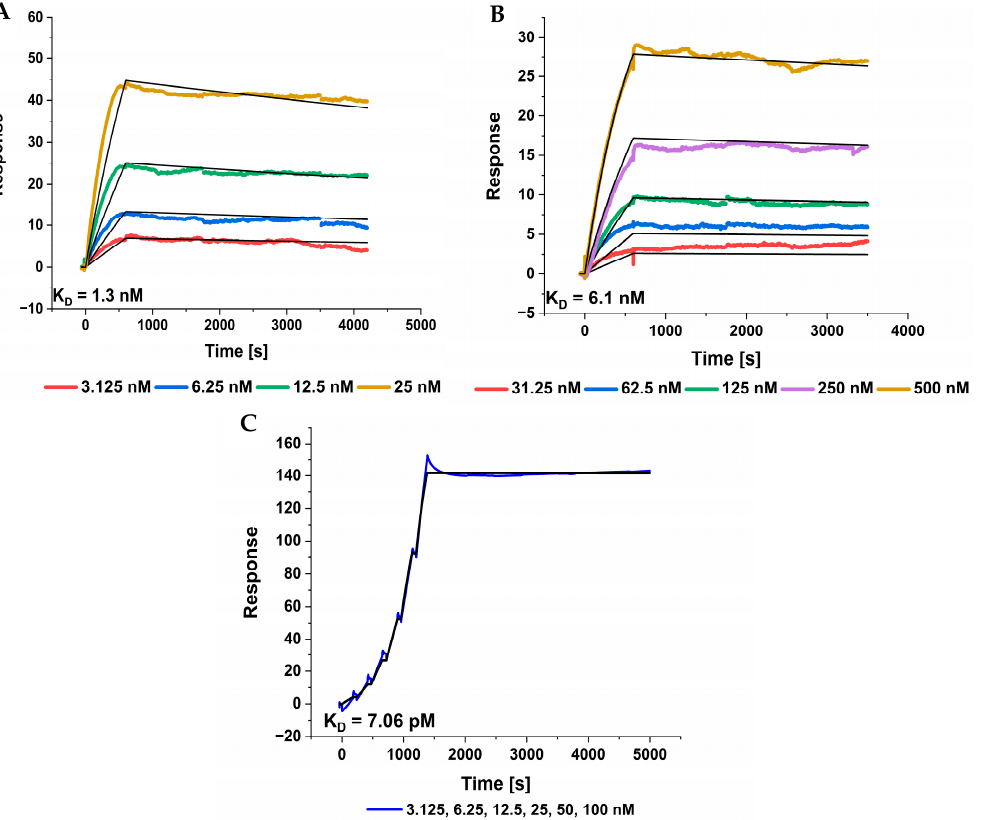
Figure 8. SPR measurements of TF2D-5 and TF2D-5a with monomeric full-length tau 441 and tau repeat region 3. ( A ) Binding curves and calculated fit for the affinity of TF2D-5 for monomeric full-length tau 441 resulted in a K D of 1.3 nM. The concentration of tau during the measurement ranged from 3.125 nM to 25 nM. ( B ) Binding affinity of TF2D-5a for monomeric full-length tau 441 was determined to be 6.1 nM. Tau was used in concentrations ranging from 31.25 nM to 500 nM. SPR measurements of A and B were recorded on a T200 Biacore instrument, the corresponding compound was immobilized on a CM5 chip from Cytiva while monomeric tau served as analyte. Tests were performed with TBS pH 7.4, 0.05% Tween20 and 10 µM DTT as running buffer. Fit calculation was completed with the internal evaluation software of the T200 Biacore. A 1:1 model was used for both fits. ( C ) Single cycle kinetic measurement of TF2D-5a to the R3 domain of tau resulted in a K D of 7 pM. The concentrations for the single cycle measurement ranged from 3.125 nM to 100 nM. Measurements of C were performed on a Biacore 8K using a CM5 chip from Cytiva. TF2D-5a was immobilized on the chip while the R3 region of tau was used as analyte. PBS pH 7.4 with 0.05% Tween20 as used as running buffer. Fit calculation was performed using the Biacore insight evaluation software and a 1:1 model. Applied tau concentrations for TF2D-5 and TF2D-5a have been finally chosen based on preliminary experiments and the estimated K D values obtained thereof. We opted to measure in multicycle measurements, where possible ( A , B ). For ( C ), this was not possible due to the extremely low off rate.